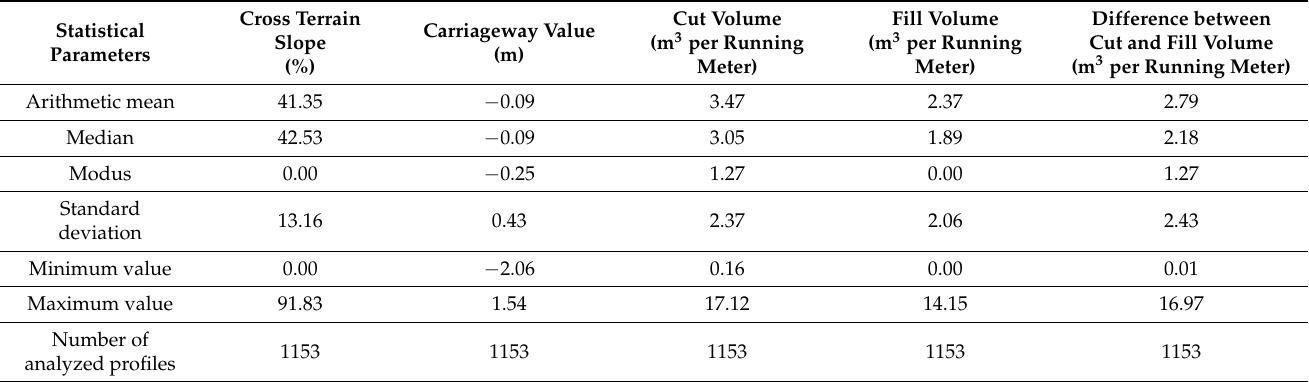
Table 4. Share of analyzed profiles by slope